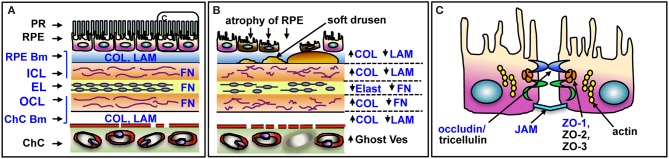
Schematic of outer retina and substrates of GzmB in BM and RPE. (A) The five layers of BM and major ECM proteins are shown in blue text. The PR and RPE sit above the BM on the RPE basement membrane. The choriocapillaris sits below BM, on its basement membrane. (B) Changes in outer retina associated with AMD pathology. RPE undergo atrophy and cell death, soft drusen deposits accumulate below RPE. Laminin, elastin, and fibronectin undergo cleavage resulting in overall ECM fragility; altered forms of collagen increase, causing thickening of BM. Choriocapillaris undergoes atrophy, with closure of some vessels, identified as ghost vessels. (C) Enlargement of box in (A) depicting tight junctional and cell adhesion proteins on RPE cleaved by GzmB in blue text. PR, photoreceptors; RPE, retinal pigment epithelium; RPE Bm, basement membrane of RPE; ICL, inner collagenous layer; EL, elastin layer; OCL, outer collagenous layer; ChC Bm, basement membrane of the choriocapillaris; COL, collagen; LAM, laminin; FN, fibronectin; Ghost Ves, closed lumen of vessel with dead endothelial cells; JAM, junctional adhesion molecules; ZO, zonula occludins. Adapted from Nita et al. (1).